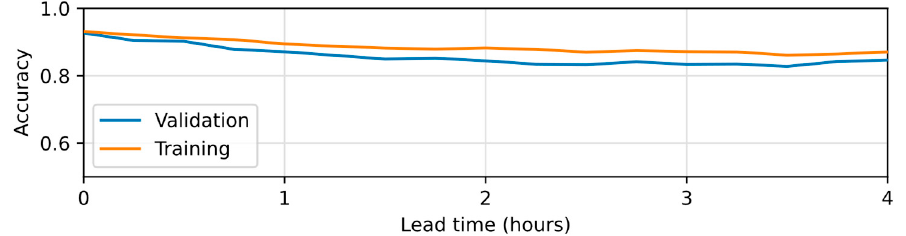
Figure 7. Accuracy of the NARX model in predicting the topological node of the SOM network in the cross-validation datasets.